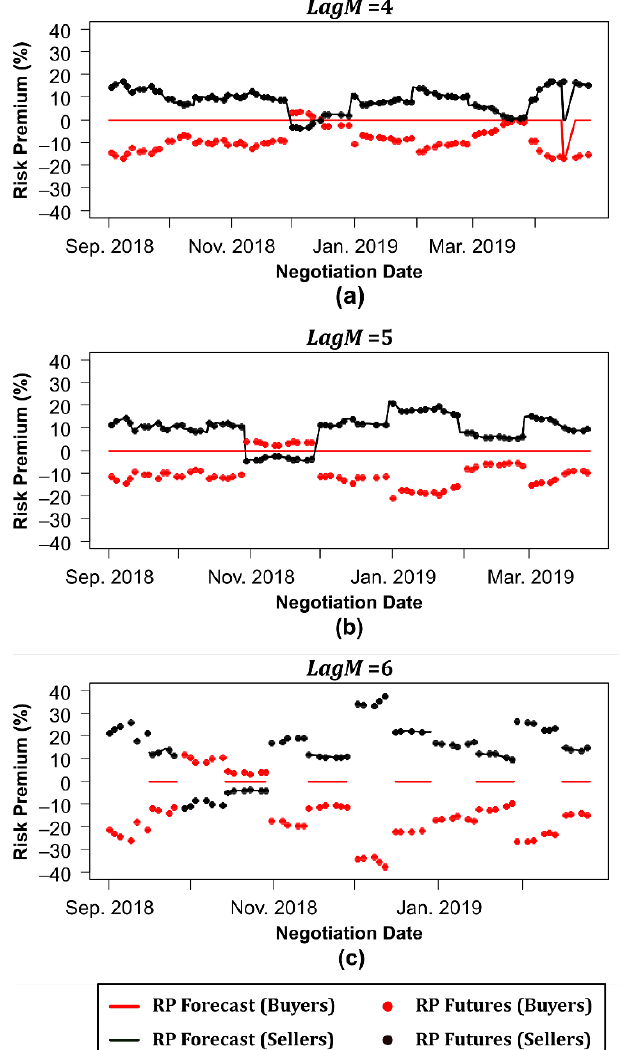
Figure 6. Risk Premium values for buyers and sellers following the predictive (RP Forecast) and the conventional (RP Futures) strategies: ( a ) for LagM = 4, ( b ) for LagM = 5 and ( c ) for LagM = 6.